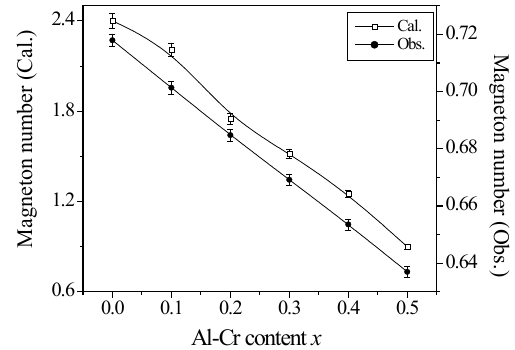
Figure 8. Plots of